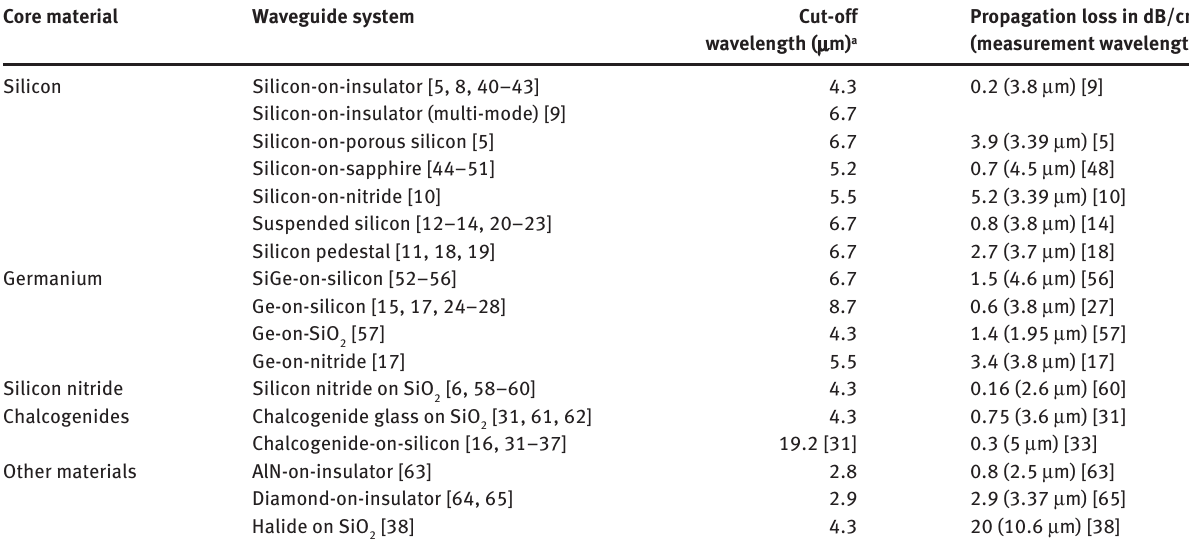
Table 1: Passive waveguide platforms for the